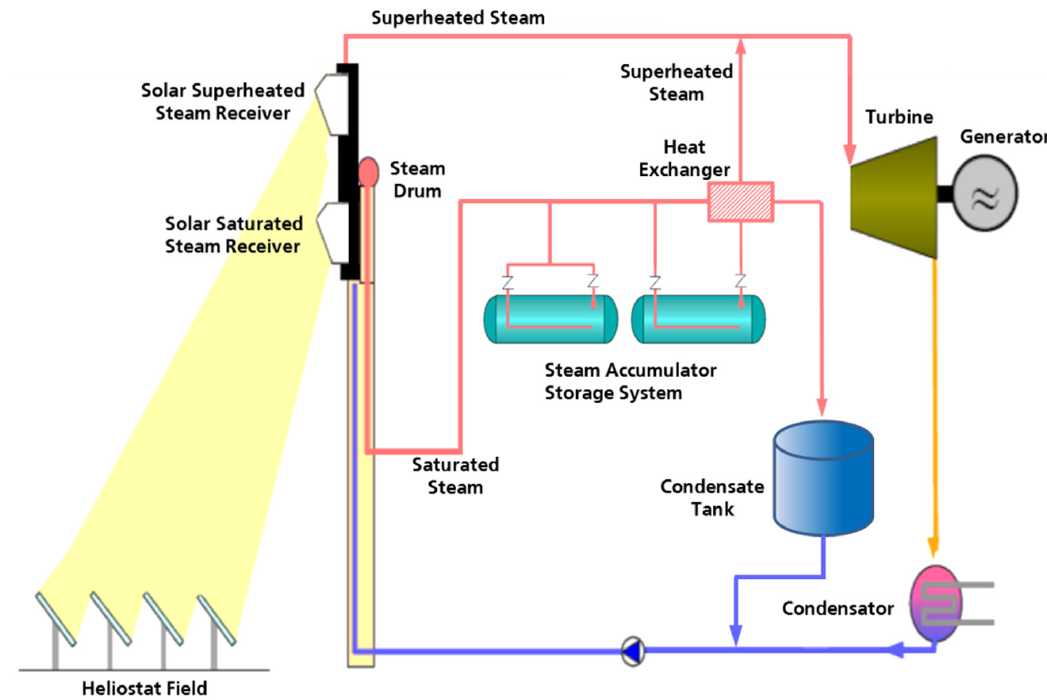
Figure 4. Scheme of 50 MW Khi Solar One plant (superheated steam) with steam accumulator TES system.